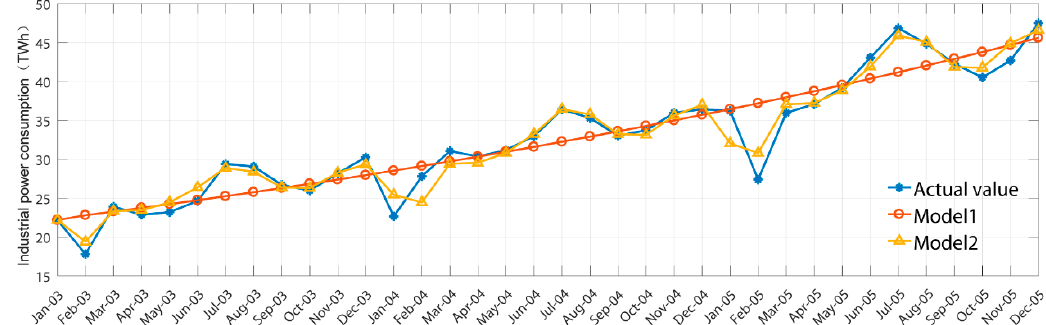
Figure 3. Comparison the actual values with the simulation results of models 1 and 2.